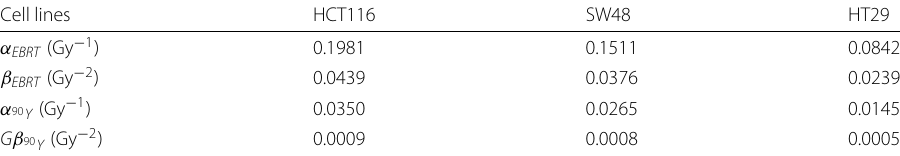
Cell lines HCT116 SW48 HT29 − 1 ) α EBRT (Gy